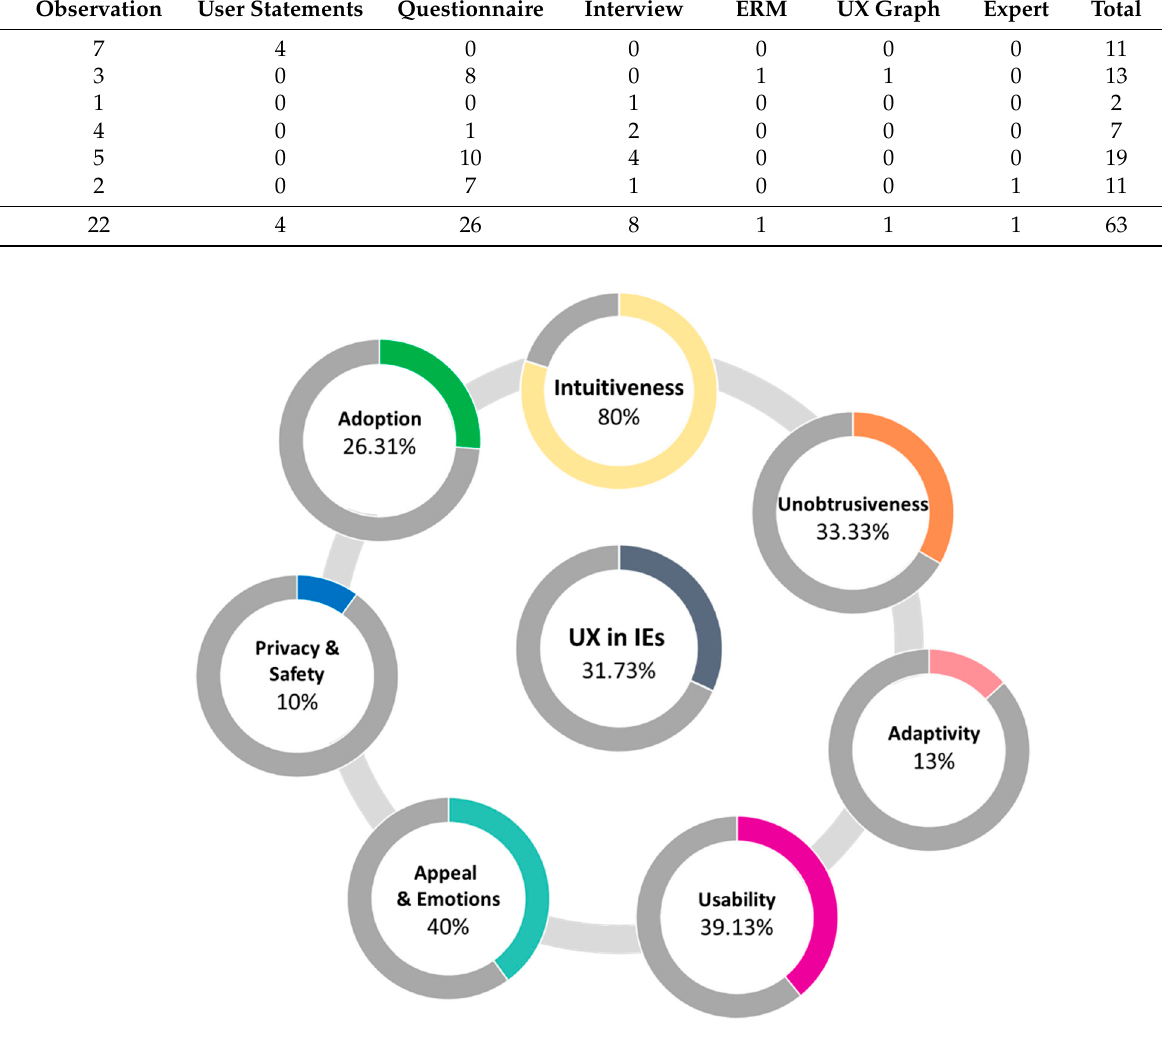
Figure 8. Proportion of IE attributes evaluated as suggested by the evaluation participants in phase A.